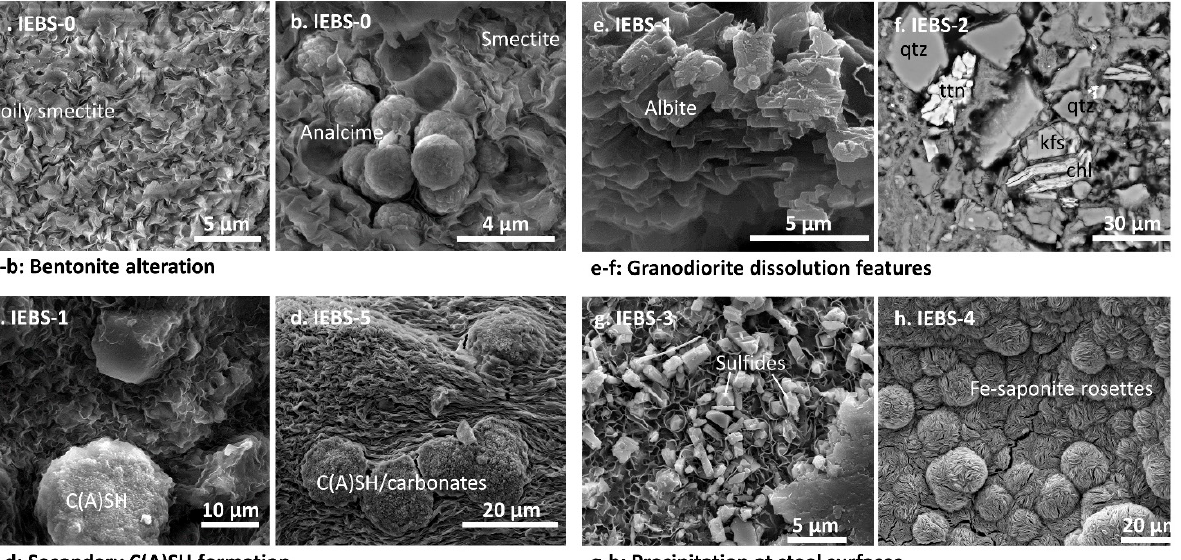
Figure 3. SE images of post-experimental solid reactants. ( a ) Characteristic foily texture of smectite reacted in GG. ( b ) CSH crystals embedded in the post-IEBS-0 smectite (Wyoming bentonite) clay matrix. ( c ) Secondary C(A)SH formed in the smectite matrix reacted in IEBS-1. ( d ) Secondary C(A)SH/carbonate phase embedded in the dried montmorillonite gel recovered from IEBS-5. ( e ) A granodiorite fragment after reaction in IEBS-4, with dissolution features (step texture). ( f ) Thin section of Grimsel granodiorite fragment after reaction in IEBS-2; note the void spaces between grains which may be related to partial dissolution of feldspar grains. ( g ) Fe-saponite (honeycomb texture) with embedded Fe,Ni,Cr-sulfide minerals (light gray crystals) on the reacted 304 SS surface. ( h ) Fe-saponite rosette at the LCS surface after reaction in